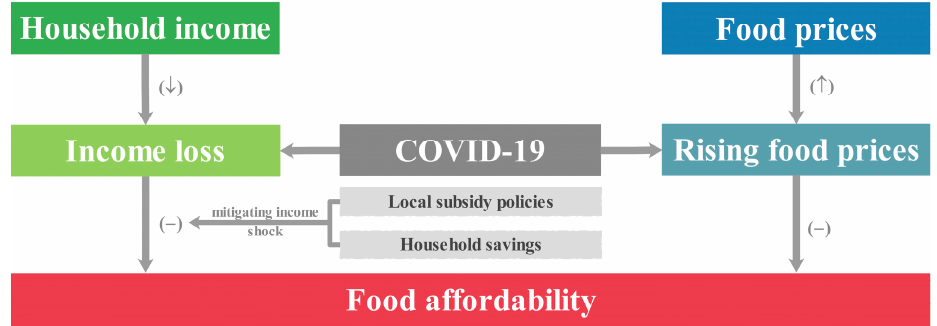
Figure 2. Combination of potential adverse factors changing food affordability during an emergency.